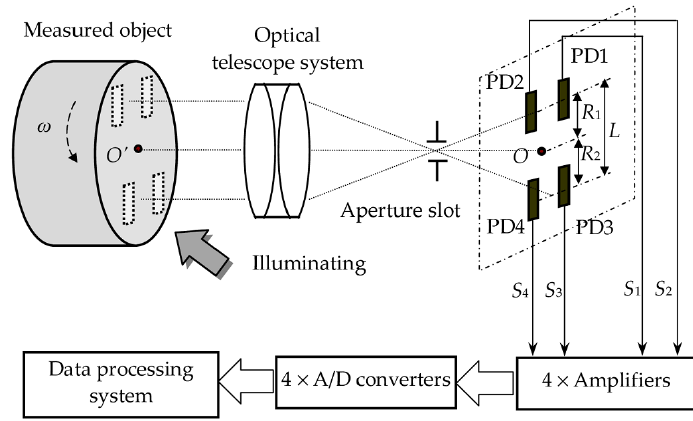
Figure 2. Schematic diagram of rotational velocity sensing system with DSC and the QPD.